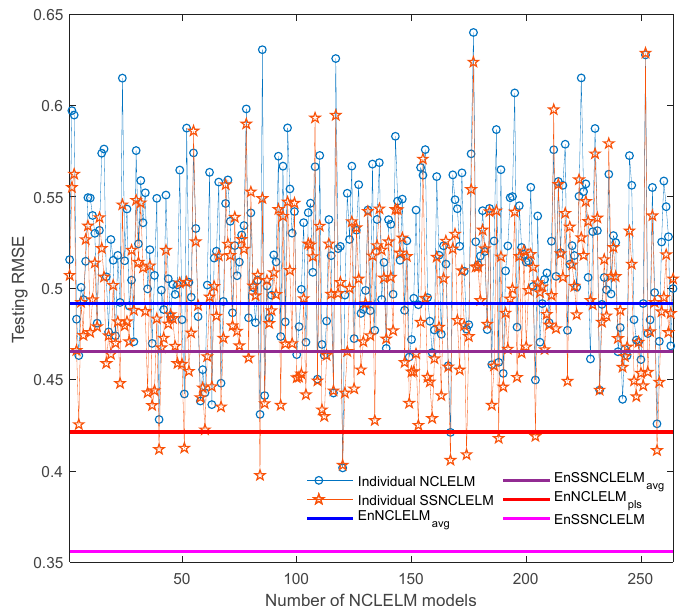
Figure 11. The performance of individual models before and after incorporating semi-supervised learning for industrial fed-batch CTC fermentation process.